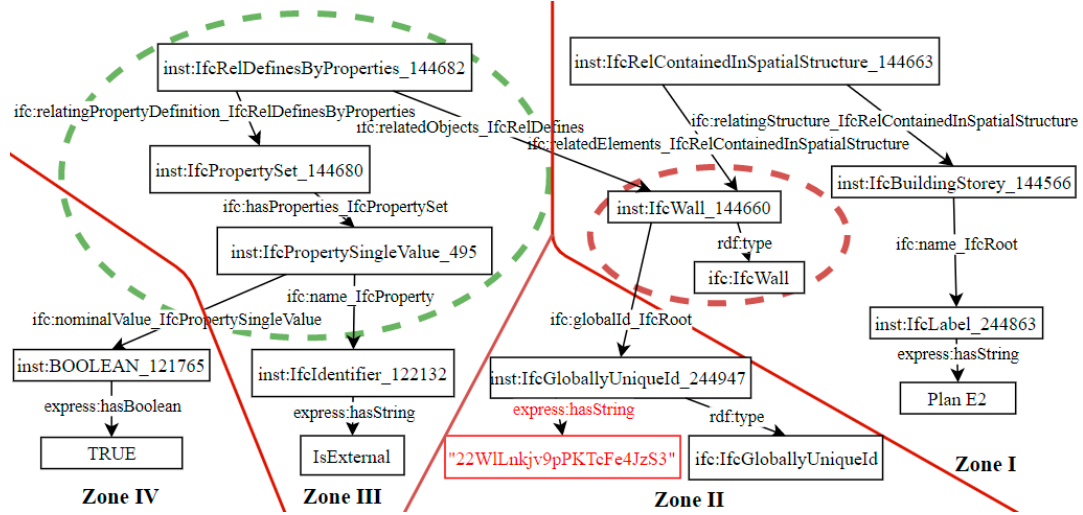
Figure 12. The structure of the shortest path of query requirements.